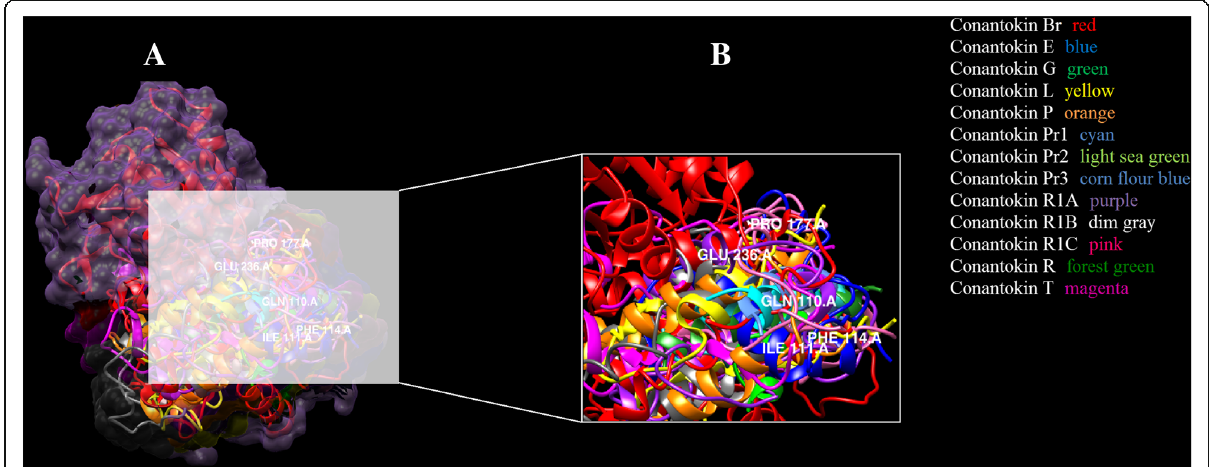
Fig. 7 a Conantokins in complex with the NMDAR (rats). b Active residues in the binding pocket highlighted (white) of NMDAR with conantokin ligands. Three-dimensional binding representation of all toxins from the ligand dataset: conantokin Br (red), conantokin E (blue), conantokin G (green), conantokin L (yellow), conantokin P (orange), conantokin Pr1 (cyan), conantokin Pr2 (light sea green), conantokin Pr3 (cornflour blue), conantokin R1A (purple), conantokin R1B (dim gray), conantokin R1C (pink), conantokin R (forest green), conantokin T (magenta) with the NMDA receptor in